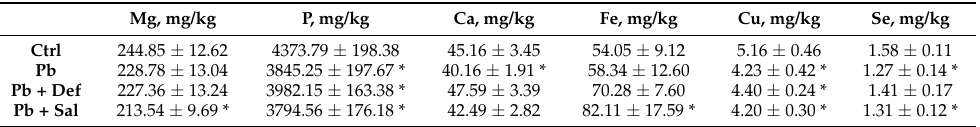
Table 3. Comparative effects of deferiprone and salinomycin on the concentrations of essential elements in the kidneys of Pb-exposed mice, n = 6. Mg, mg/kg P, mg/kg Ca, mg/kg Fe, mg/kg Cu,